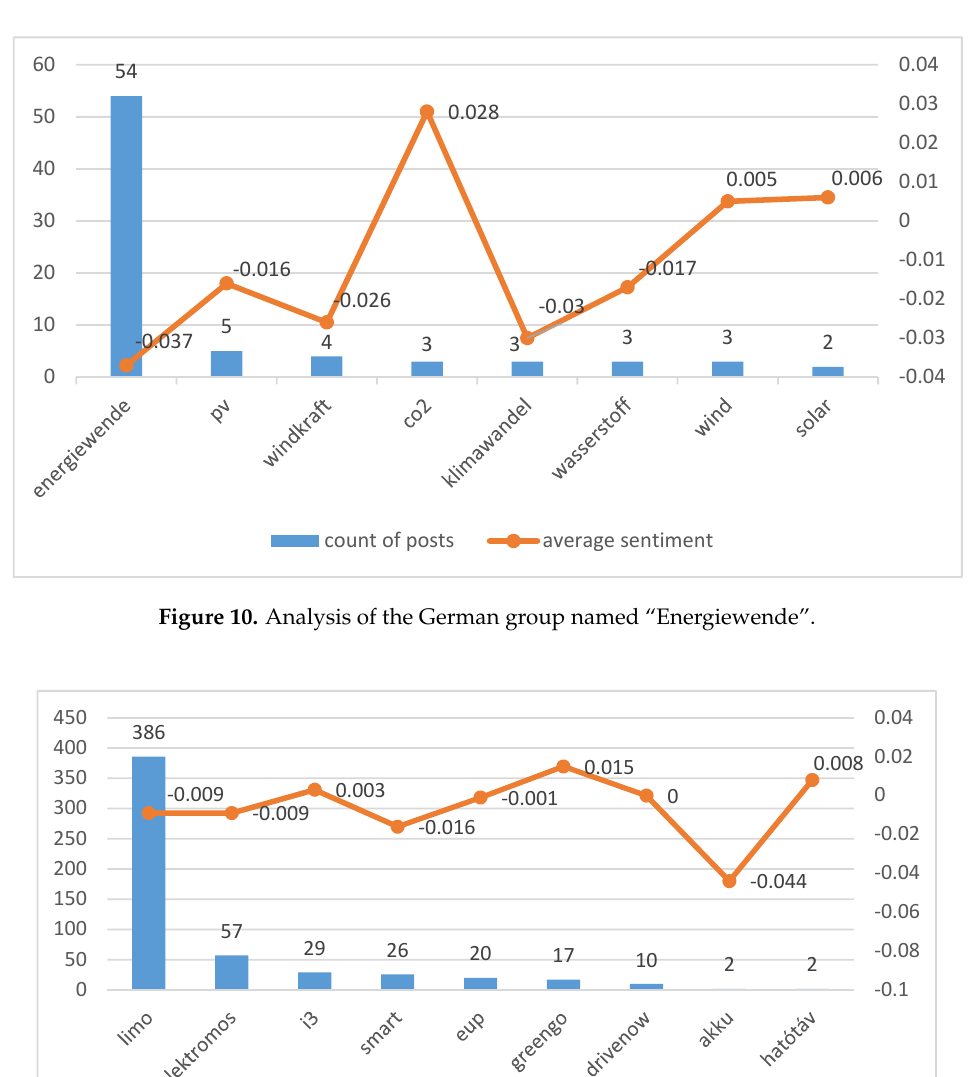
Figure 10. Analysis of the German group named “Energiewende”.